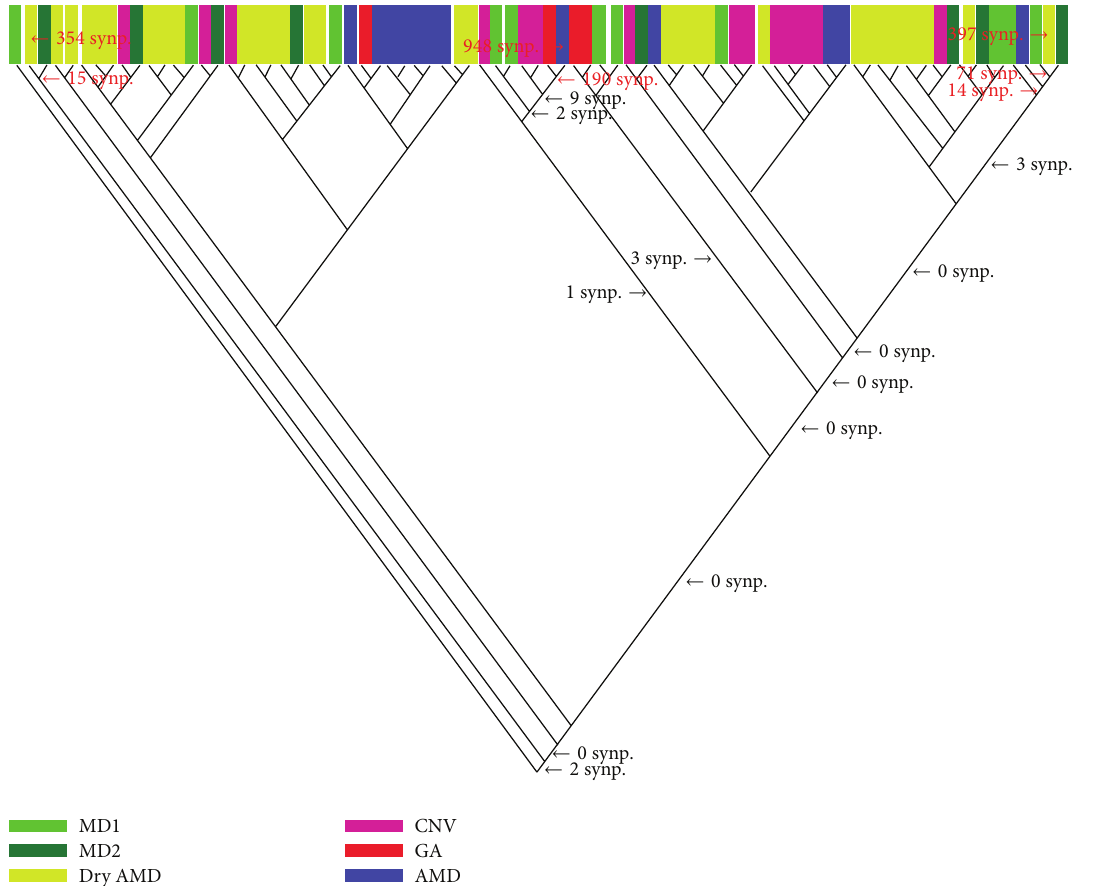
Figure 2: Cladogram of RPE-choroidal specimens. The number of synapomorphies for major nodes is indicated to the right of the nodes, as well as for some specimens used as examples in the pathways analysis (numbers in red). Colors indicate AMD phenotypic